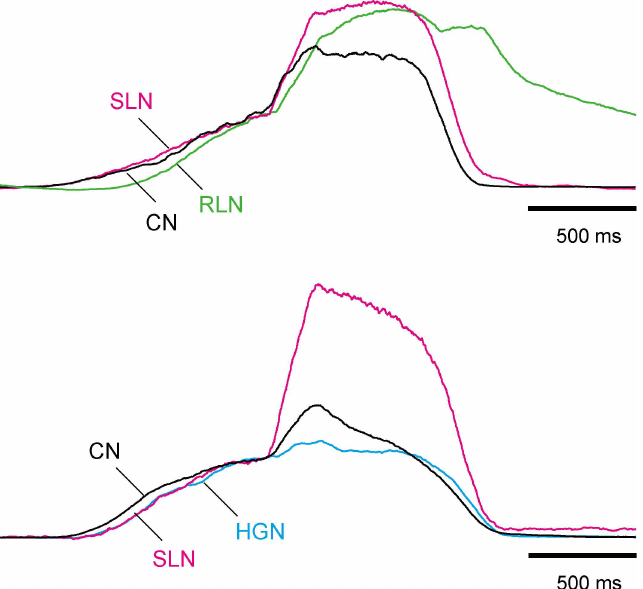
Fig 3. The discharge patterns of the CN, SLN, RLN, and HGN in hypercapnic acidosis. The averaged traces from two preparations shown in Fig 1 were normalized via the peak amplitudeof the pre-I